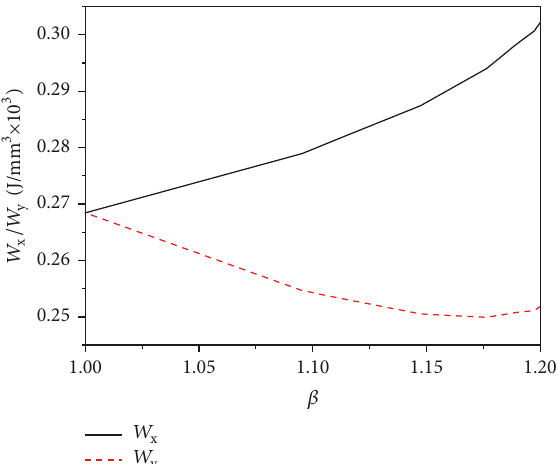
Figure 12: Relationship between 𝑊 x ( 𝑊 y ) and the isotropic factor 𝛽 for a rubber composite reinforced with aramid fibers: 𝑙 f =1.5 mm, V f =0.0049.